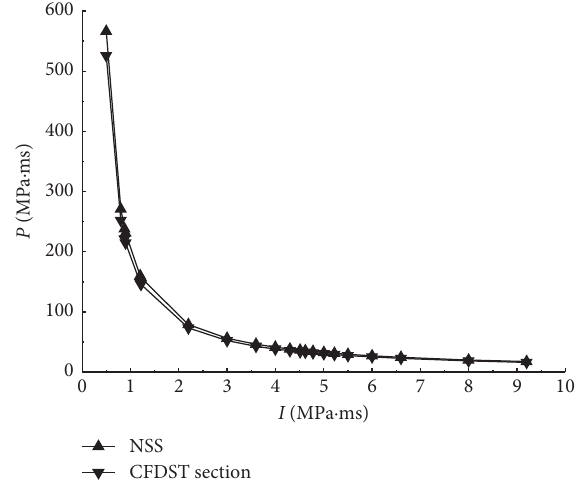
Figure 21: Pressure-impulse (P-I) curve of the NSS CFST column and CFDST column.